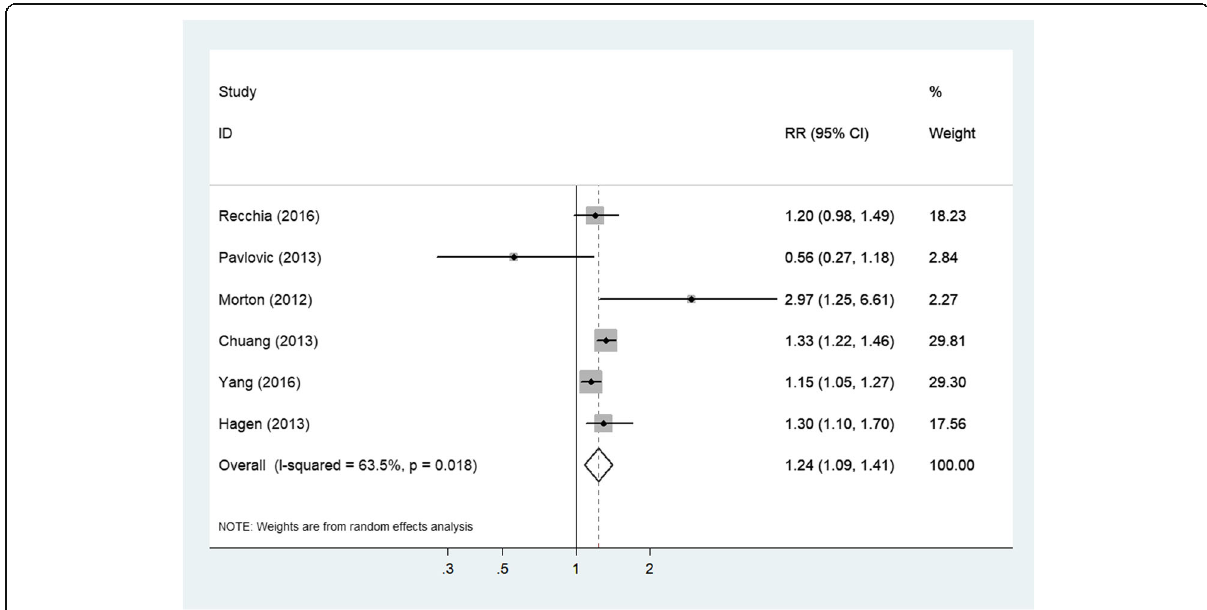
Fig. 2 Forest plot of the association between any headache and the risk of all-cause dementia